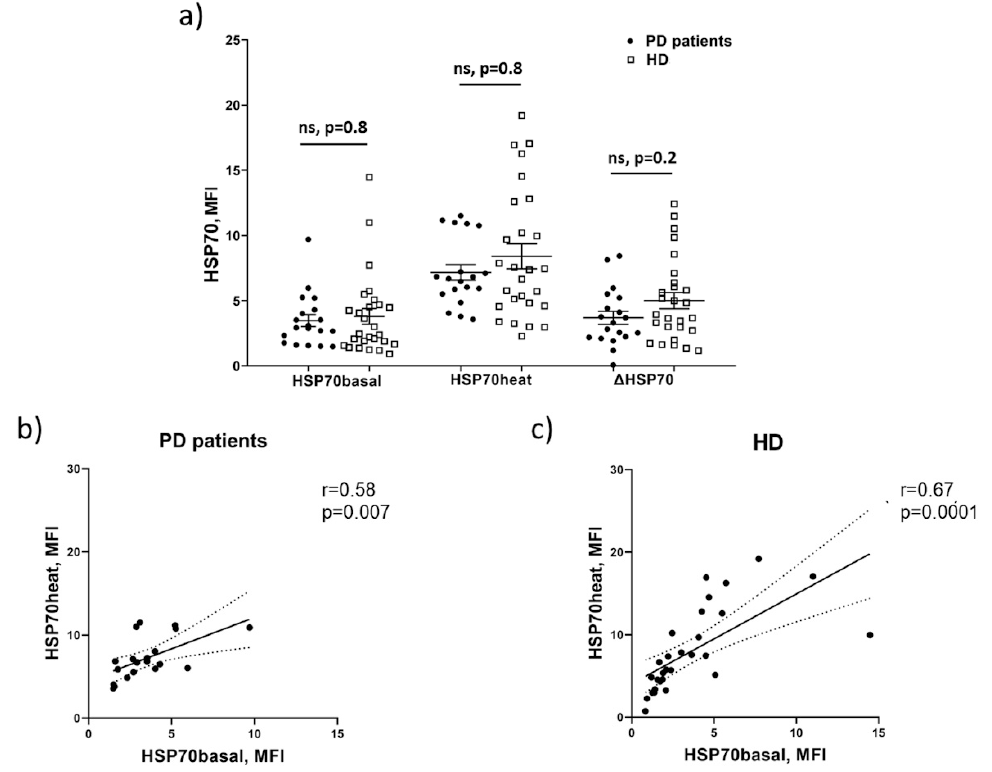
Figure 1. The level of the intracellular HSP70 pool (Hsc70 + Hsp70) in PBMC. ( a ) Basal (HSP70basal), heating-induced (HSP70heat) HSP70 levels, and ∆ HSP70 in PD patients ( n = 19) and HDs ( n = 27); ∆ HSP70 values were calculated as ∆ HSP70 = HSP70heat − HSP70basal; ( b ) a correlation analysis between HSP70basal and HSP70heat levels in PBMC isolated from PD patients ( c ) from HDs. The results are presented as means of fluorescence intensity, corrected for background fluorescence of the control sample (MFI). Solid lines, mean ± SEM; ns, non-significant. ( b , c ) Pearson’s correlation coefficient was used; dotted line, 95% confidence